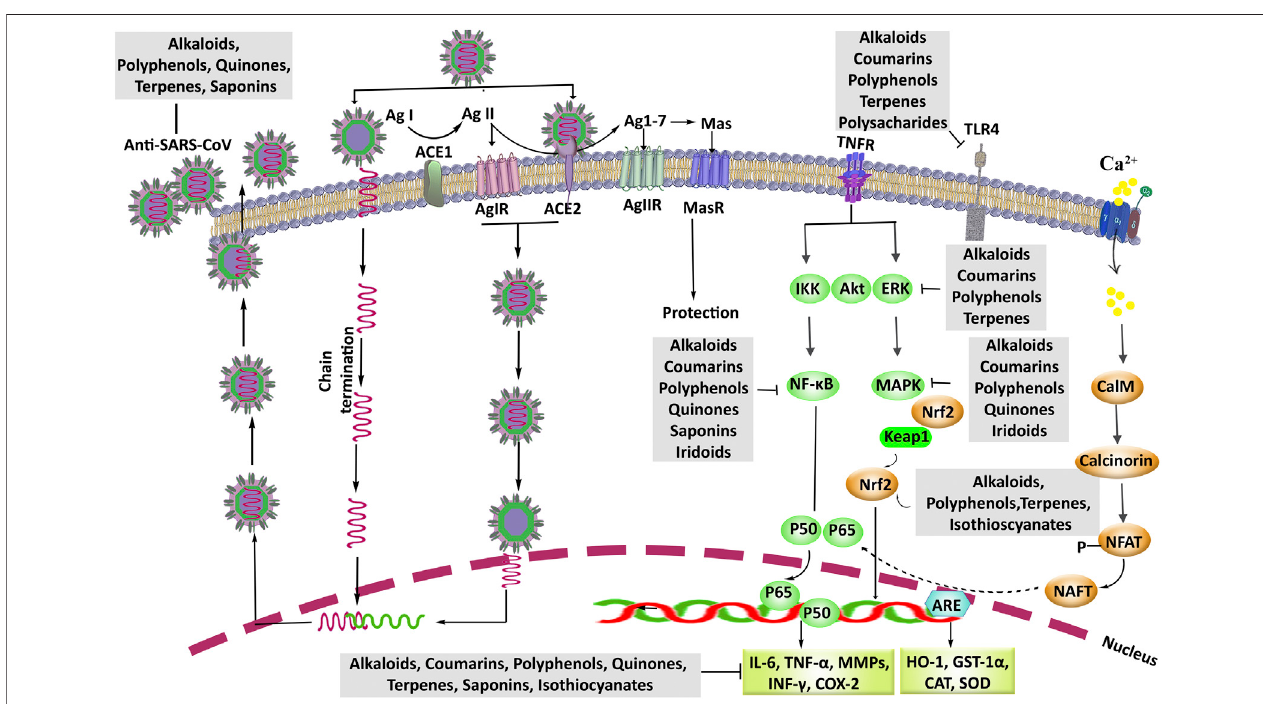
FIGURE4| Thepharmacologicalmechanismsandtherapeutictargetsofphytochemicalsagainstcoronavirus-associatedlunginjury.ACE,angiotensin-converting enzyme; Ag, angiotensin; Akt, protein kinase B; ARE, antioxidant response element; Anti-SARS-CoV, anti-severe acute respiratory syndrome coronavirus; Ca 2+ , calcium; CalM, calmodulin; NAFT, nuclear factor of activated T cells; CAT, catalase; COX-2, cyclooxygenase-2; ERK, extracellular signal-regulated kinase; GSH, glutathione; GST-1 α , glutathione S-transferase; HO-1, heme oxygenase-1; IFN γ , interferon γ ; IL, interleukin; IKK, inhibitor ofnuclear factor- κ B (I κ B) kinase; MAPK, mitogen-activated protein kinase; MMPs, matrix metalloproteinases; NF- κ B, nuclear factor- κ B; Nrf2, nuclear factor erythroid 2-related factor 2; SOD, superoxide dismutase; TLR4, toll-like receptor 4; TNF- α , tumor necrosis factor- α ; TNFR, TNF receptor.